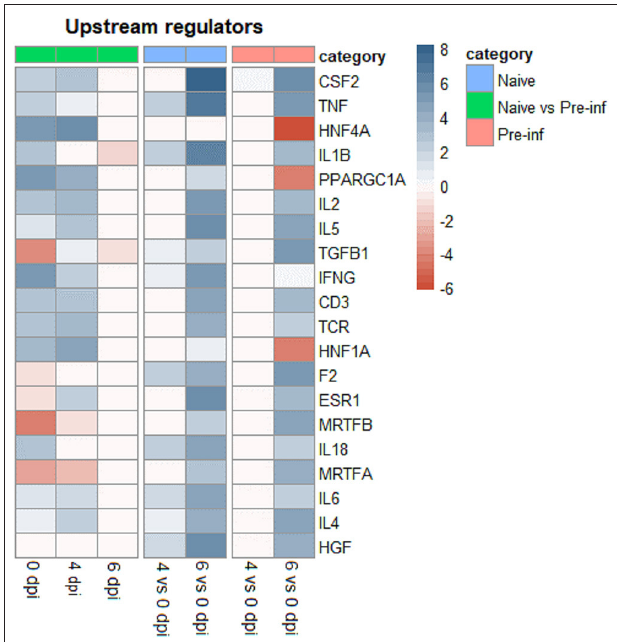
FIGURE 3 | Top 20 upstream regulators of differently expressed genes for naïve and pre–infected (Pre–inf) kids comparing 0 vs. 4 and 6 days post–infection (dpi) and pre–infected vs. naïve at 0, 4, and 6